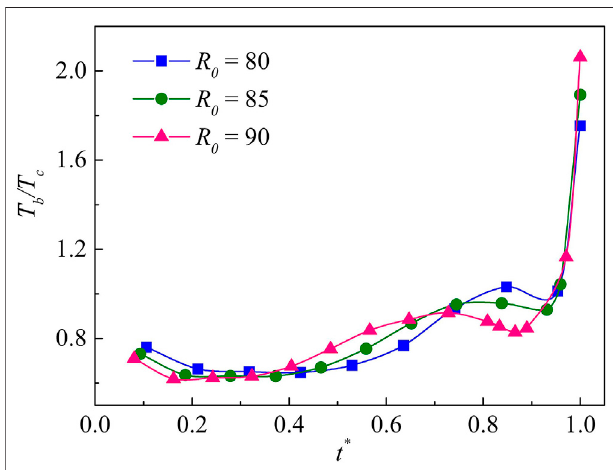
FIGURE 13 | Bubble temperature vs. time during the fi rst collapse for several values of R 0 .